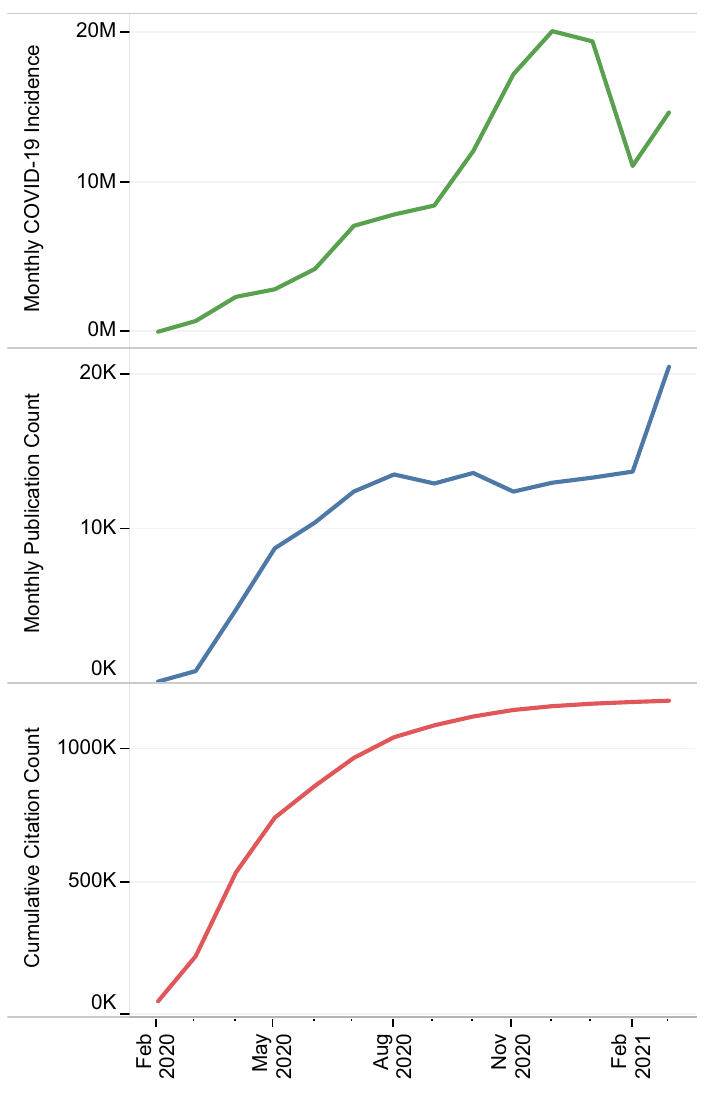
Fig 1. Monthly trends of global COVID-19 incidence, publications, and cumulative count of citations. 38.6% (Fig 4). Among the countries with at least 1000 publications related to COVID-19, Swit- zerland with 2118 (74.7%) international publications, followed by Sweden 1184 (74.4%) and Denmark 785 (71.0%) were the top three countries in the percentage of international collabo- ration (S2 Fig). The most collaborating countries were the US, the UK, and Italy, with Degree values of 31668, 21517, and 15529, respectively. Taking the total publication count into account, the US with Degree to publications ratio of 1.42 was the most collaborating among countries with at least 1000 publications on COVID-19, followed by China (1.40), and India (1.38). The UK-US, the China-US, and the Italy-US were the most collaborative pairs with 3112, 2611, and 2284 joint publications related to COVID-19, respectively. In terms of the Normalized Degree Cen- trality, the US had collaborated with 92.0% of countries, followed by the UK (82.6%), Italy (76.1%) (Table 2 and S8 Table).